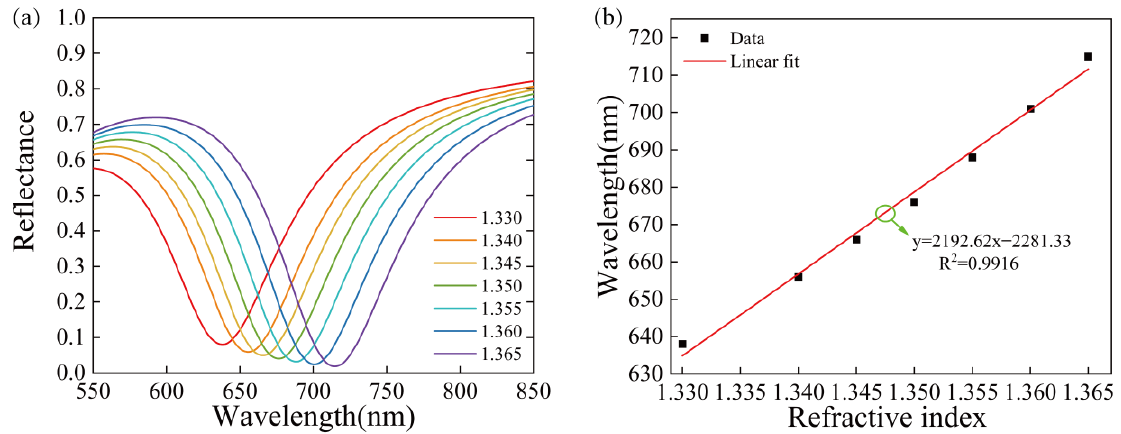
Figure 3. The reflectance curves of the Au structure, ( a ) SPR curves for different refractive indices of the pure gold film structure, ( b ) relationship between the refractive index and the resonance wavelength and linear fitting.